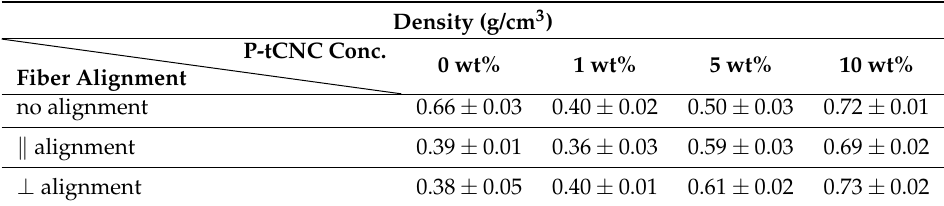
Table 3. Densities of electrospun PU/P-tCNC nanocomposite fibrous mats with different fiber alignments (no alignment, (cid:107) , and ⊥ ). The mat density increases with increasing P-tCNC concentration (weight fraction of P-tCNCs in